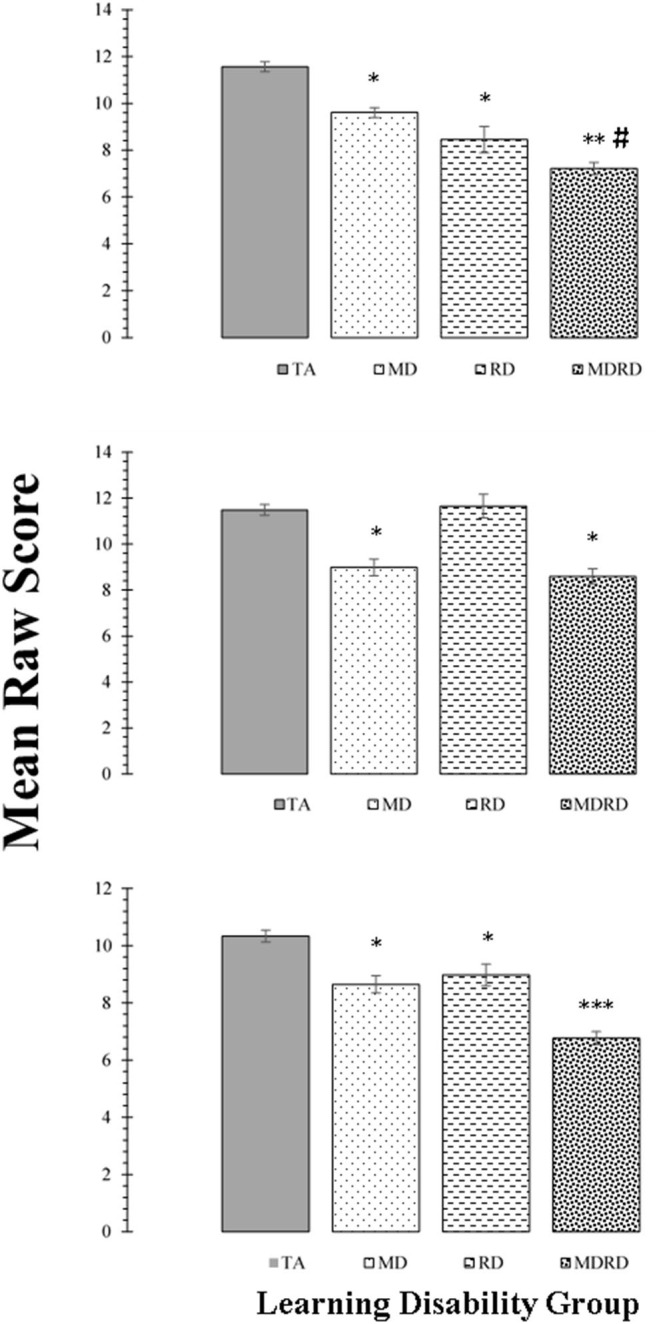
Top Panel: Mean scores for the WAIS-R Vocabulary subtest. Middle Panel: Mean scores for the WAIS-R Block Design subtest. Bottom Panel: Mean scores for the WAIS-R Digit Span subtest. For all panels, bars represent one standard errors. Asterisks summarize the results of post hoc Tukey test comparisons: “*” difference from the typical achievement (TA) control group at p < 0.05; “**” significant difference from the mathematical disability (MD) group at p < 0.05; “***” significant difference from the reading disability (RD) group at p < 0.05. The symbol “#” indicates a marginally significant trend at 0.05 < p < 0.10 on post hoc Tukey test. For the Vocabulary subtest: TA > MD (1.95, [CI: −0.92 to 2.98], p < 0.01); TA > RD (3.10, [CI: 1.90 to 4.30], p < 0.01); TA > MDRD (4.34, [CI: 3.39 to 5.29], p < 0.01). MD > MDRD (2.39, [CI: 2.39 to 3.54], p < 0.01). # RD > MDRD (1.24, [CI: −0.06 to 2.54], p = 0.069). For the Block Design subtest: TA > MD, (2.50, [CI: 1.36 to 3.64], p < 0.01); TA > MDRD (2.89, [CI: 1.84 to 3.94], p < 0.01). For the Digit Span subtest: TA > MD (1.68, [CI: 0.74 to 2.62], p < 0.01); TA > RD (1.36, [CI: 0.26 to 2.45], p = 0.01); TA > MDRD (3.57, [CI: 2.69 to 4.44], p < 0.01). MD > MDRD (1.88, [CI: 0.83 to 2.93], p < 0.01). RD > MDRD (2.21, [CI: 1.02 to 3.40], p < 0.01).